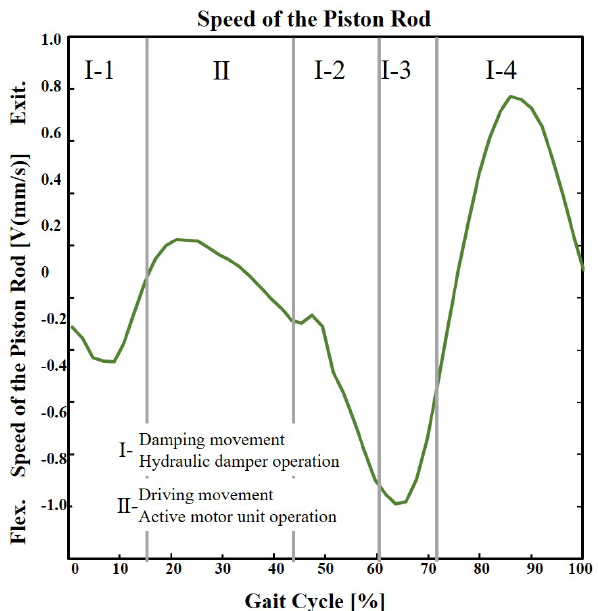
Figure 8. Equivalent diagram of the HPAK.